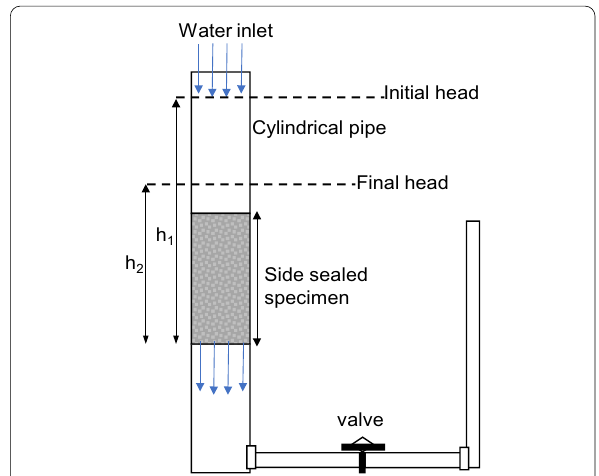
Fig. 7 Schematic of the falling head test method (Batezini & Balbo,